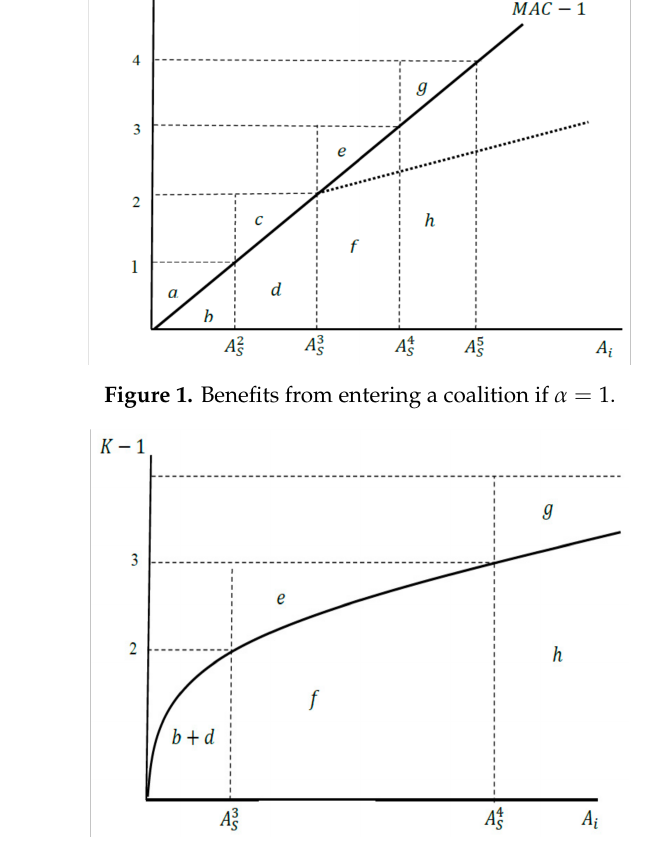
Figure 2. Benefits from entering a coalition if α <